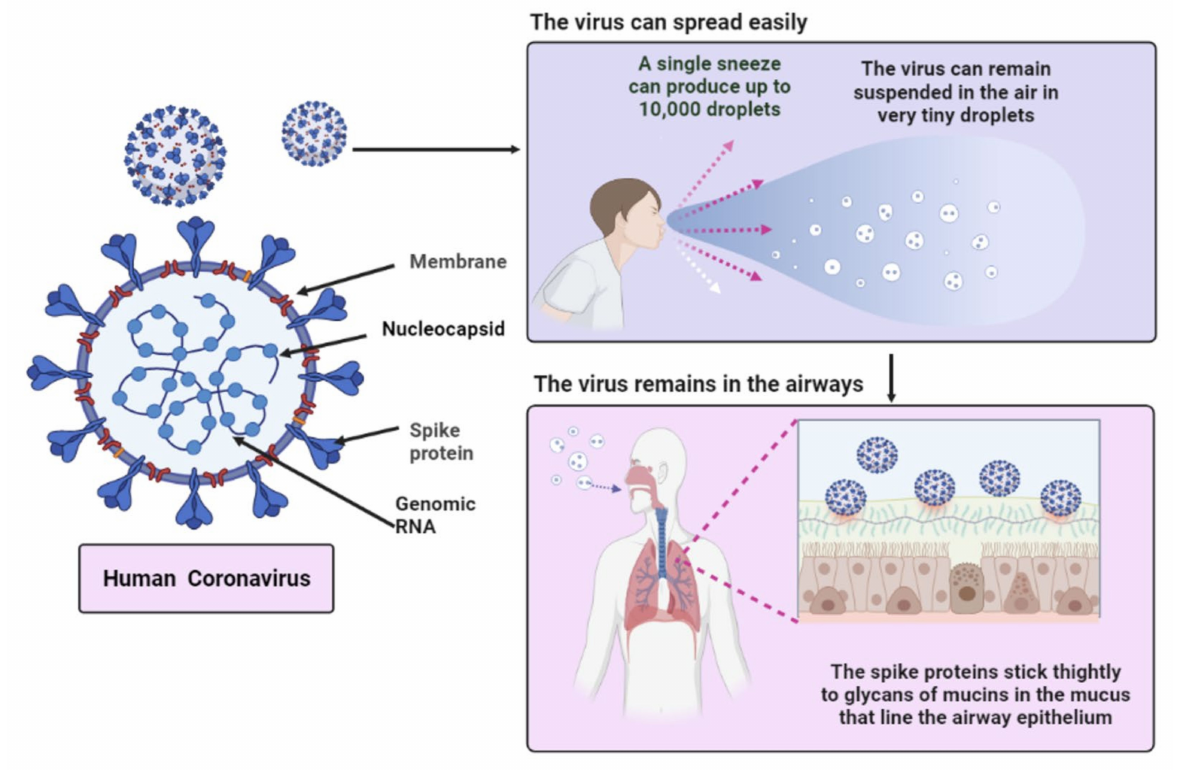
Figure 2. Structure and spread mechanism of the human coronavirus (Created with